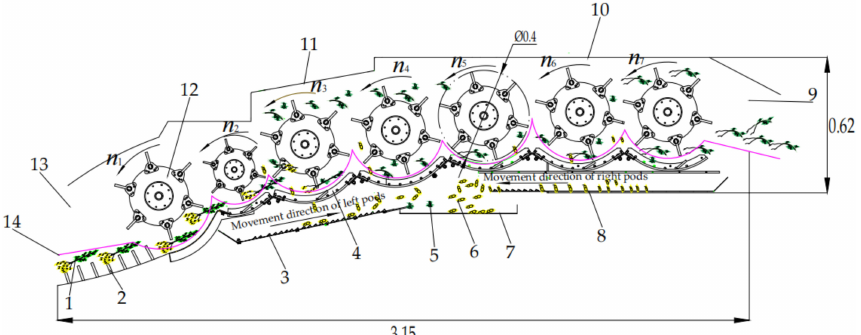
Figure 4. Working principle diagram of a tangential-flow pod-pickup drum. 1. Peanut